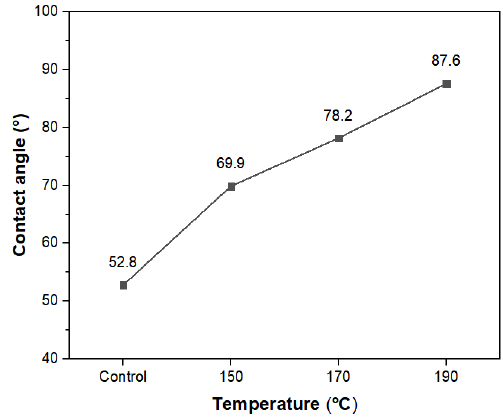
Figure 4. Contact angle analysis of Masson pine wood as a function of temperature.